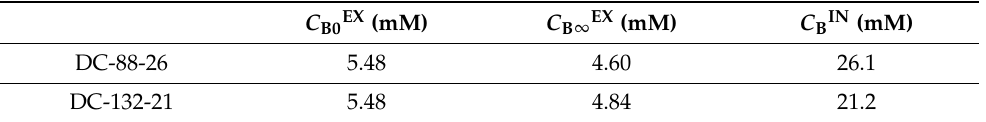
Figure 3. ( a ) Formation of a boron–azomethine-H complex. ( b ) Transmission spectra of the 100- fold-diluted external borax solutions containing azomethine-H before and after C-88 immersion. Absorbance at a wavelength of 410 nm is used for evaluating the borate ion concentration. Table 1. Borate ion concentrations in the external solutions before and after gel immersion ( C B0EX and C B ∞ EX , respectively) and in the DC gels ( C BIN